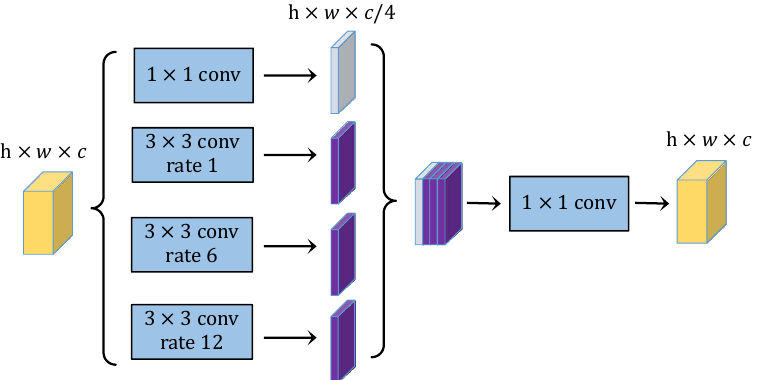
Figure 7. The structure of ASPP module with deep separable convolutions proposed in Deeplab v3+